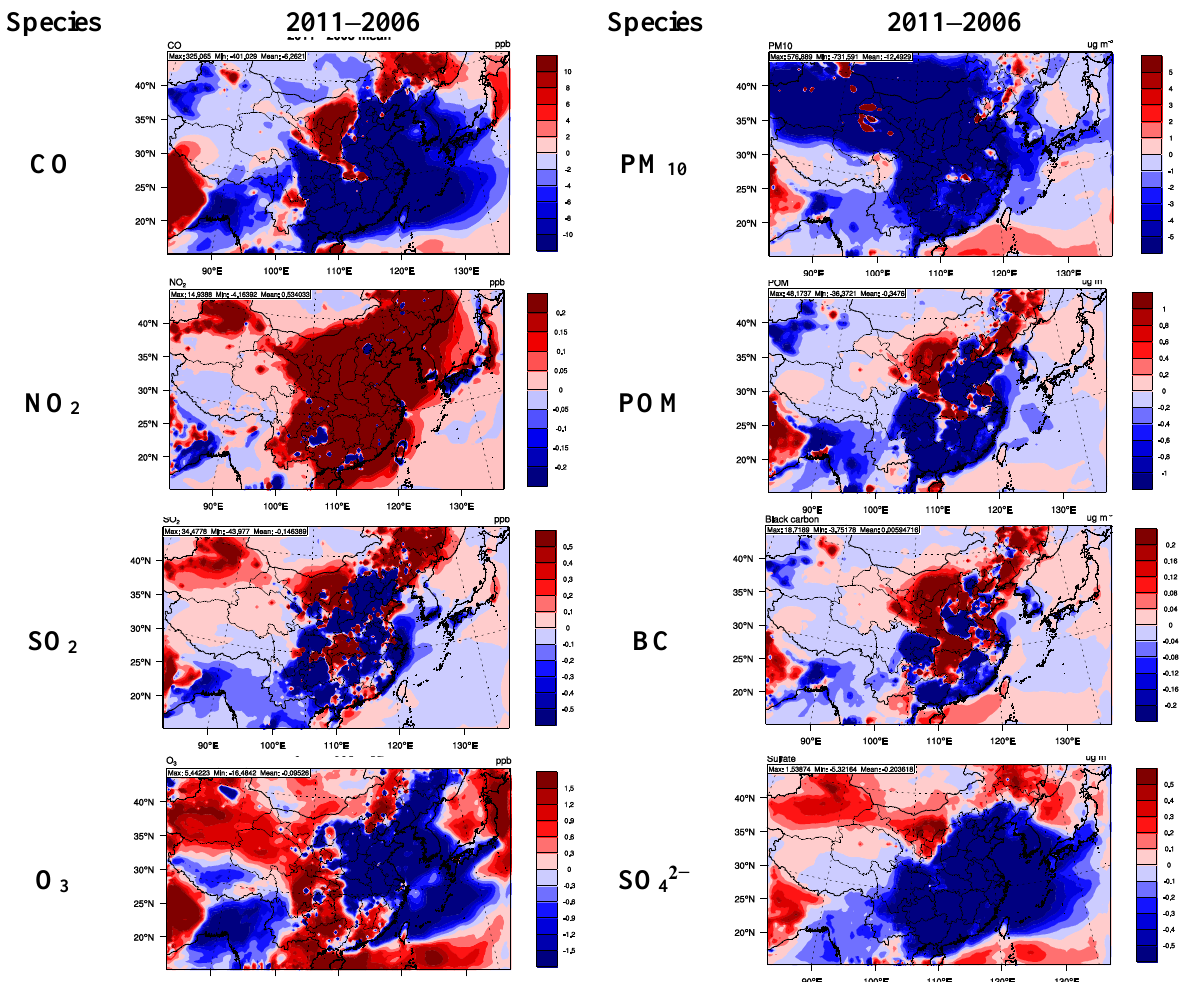
Figure 10. Annual mean absolute changes of mixing ratios of surface CO, NO 2 , SO 2 , O 3 , and mass concentrations of surface PM 10 , POM, BC, and SO 42− between 2011 and